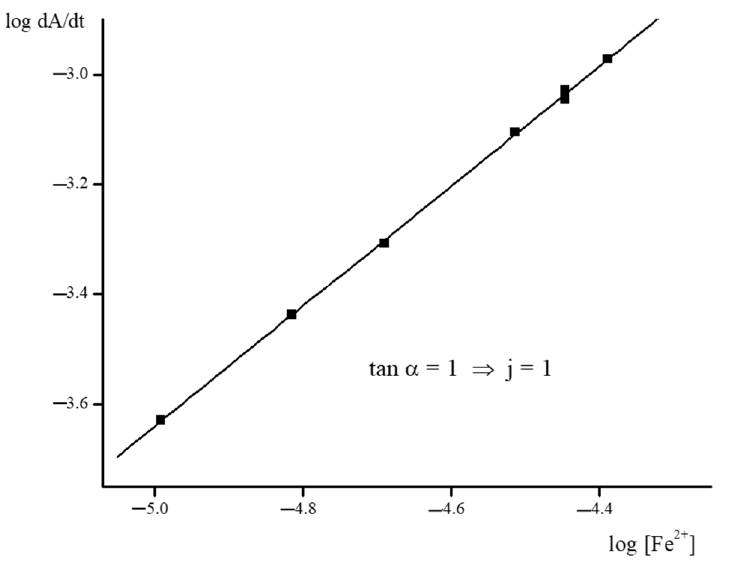
Figure 3. Determination of the synthesis reaction order for the complex FeOx 3 (BCH 3 ) 2 ( 5 ) with respect to the concentration of Fe 2+ ions at [H 2 Ox] = 1.5 × 10 − 3 mol L − 1 , [CH 3 B(OH) 2 ] = 5 × 10 − 3 mol L − 1 and pH =